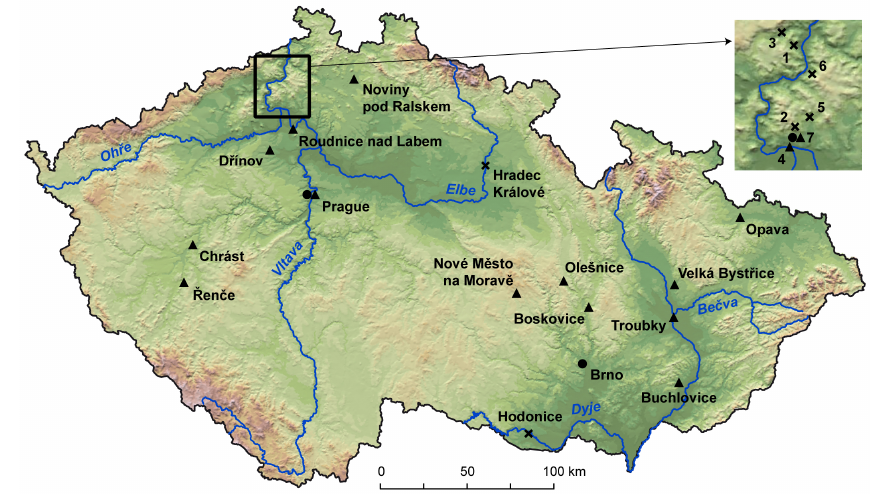
Figure 1. The Czech Republic, showing places from which meteorological observations (circles) and documentary weather reports (triangles) were obtained for the purposes of this study. Locations of other places reported in the text (crosses). Key: 1 – Bohynˇe, 2 – Chudoslavice, 3 – Jílové, 4 – Litomˇeˇrice, 5 – Tˇrebušín, 6 – Vitín, 7 – Žitenice.